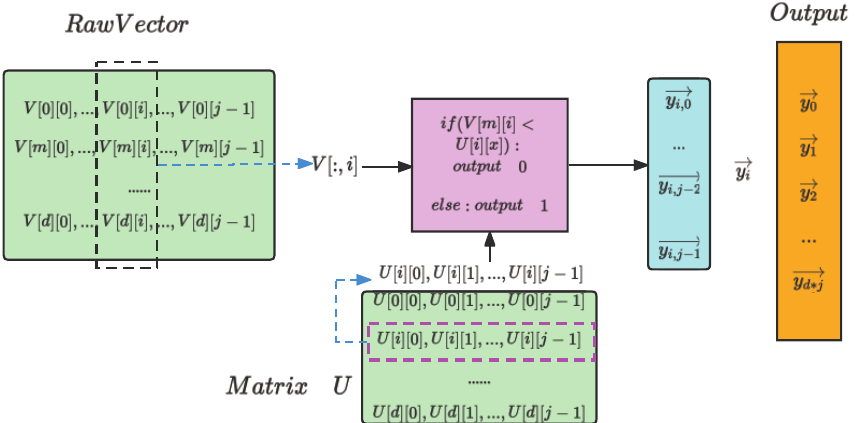
Figure 2. Transform Mechanism. RawVector was the input and y was the output. We assumed the size of input was d , and i represented the value of i th feature of input. U was a matrix containing each feature’s different values, its shape was [ d , j ] ( j was not fixed in different rows but was definitely smaller than